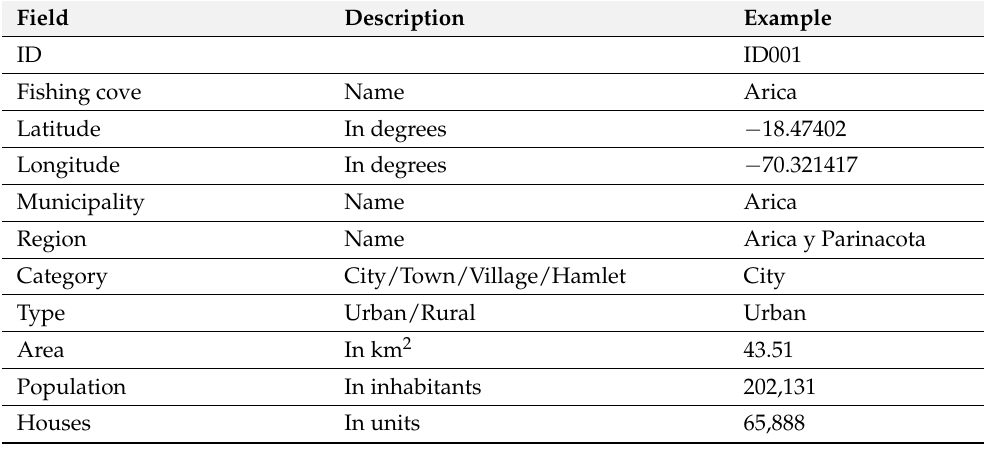
Table 1. Fields used in the inventory for each coastal settlement and its application to the city of Arica. In ARClim, data for all coastal settlements can be downloaded by clicking the button Exportar datos”, at the top right corner of the site https://arclim.mma.gob.cl/atlas/view/asentamien\T1 \textquotedblrighttos_costeros/ (accessed on 12 October 2022).